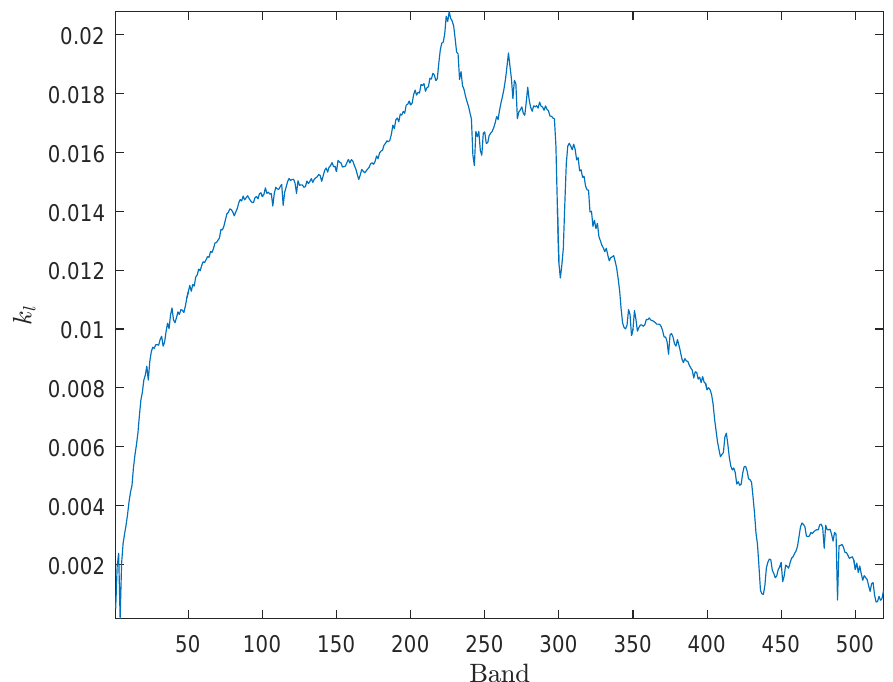
Figure 5. The calibrated noise parameters k l of the employed hyperspectral camera.